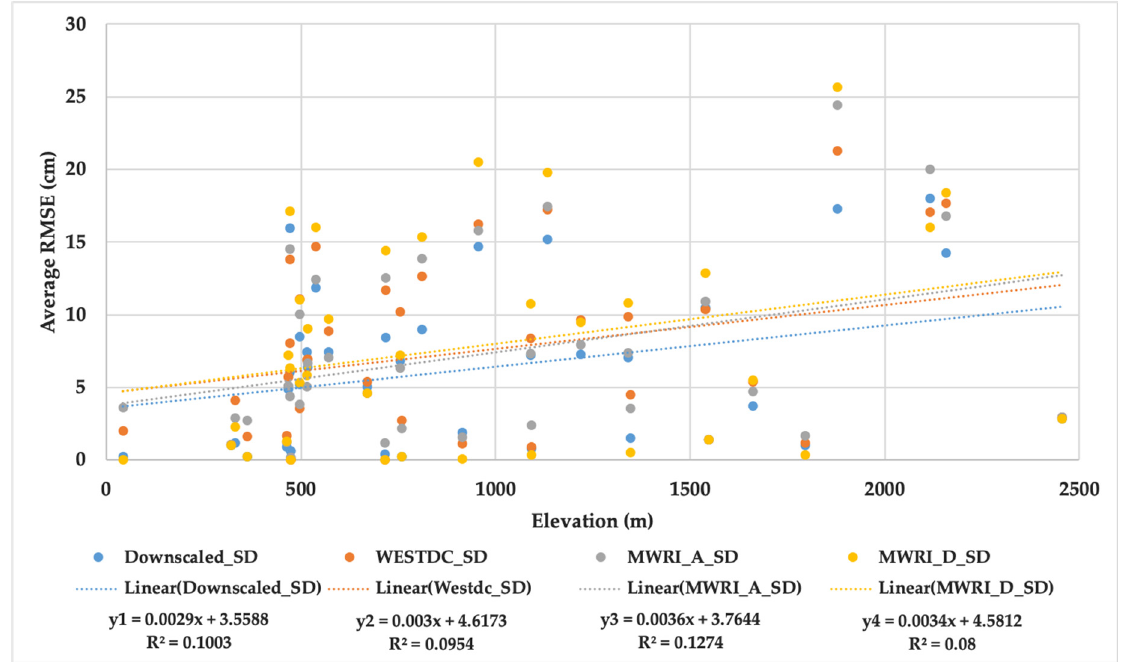
Figure 10. Average RMSE comparison of four snow datasets in each station and relationship between elevation and RMSE.